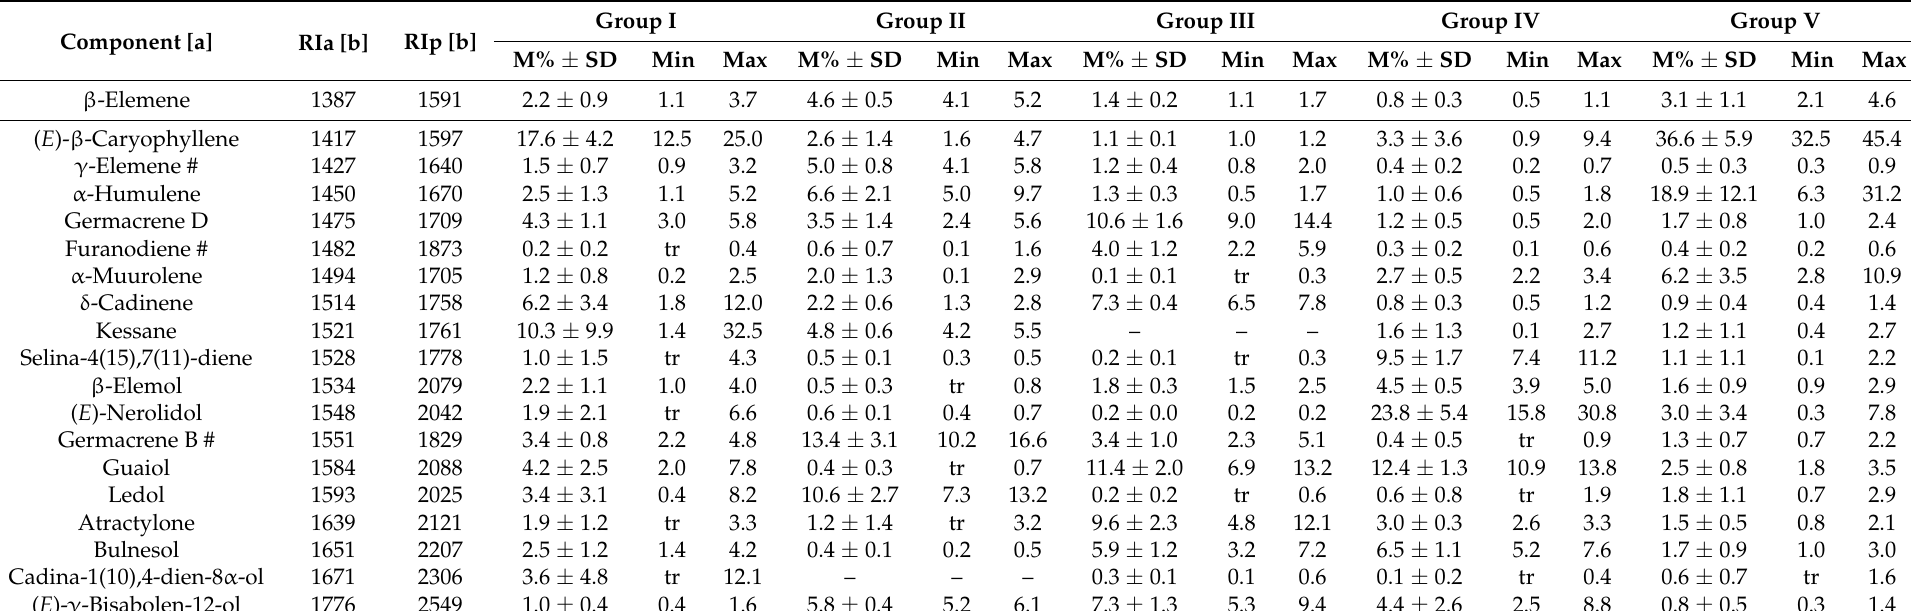
Table 4. Chemical variability of the main constituents of leaf essential oil from Neuropeltis acuminata